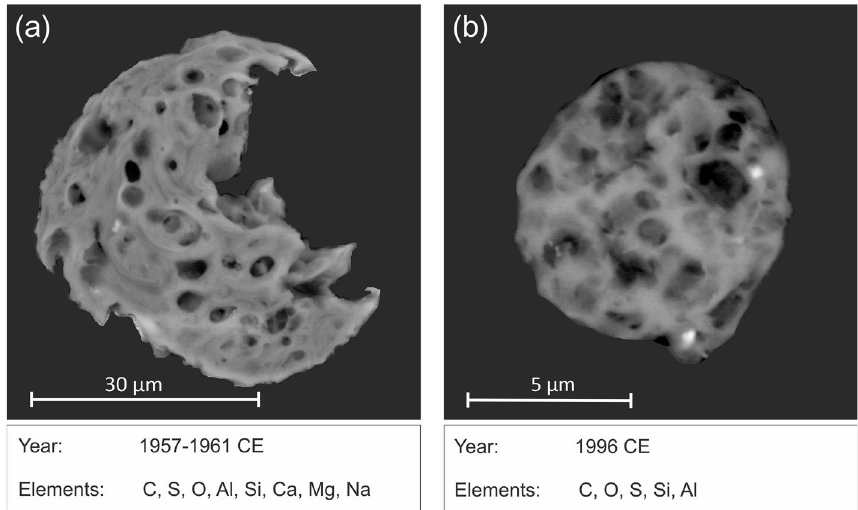
Figure 2. Scanning electron microscope (SEM) images. Two SCPs from the Palmer ice core showing the year of deposition and elemental composition determined by energy dispersive X-ray spectroscopy (EDS). Elements presented in order of relative intensity. SEM images presented with background filter